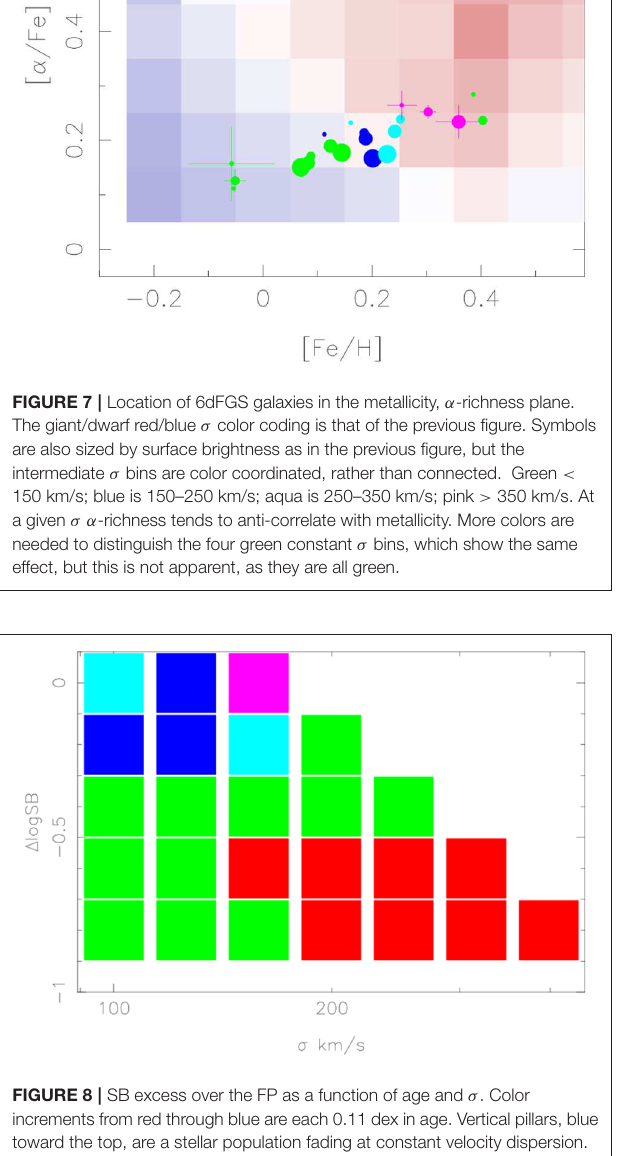
type, a second parameter in the scaling relation does become apparent (Cortese et al., 2014; Tonini et al., 2014). Ultra diffuse galaxies (van Dokkum et al., 2015) have now arrived at an opportune time. There are clearly different processes involved in forming them from those that make normal galaxies and shape the well-populated plane.